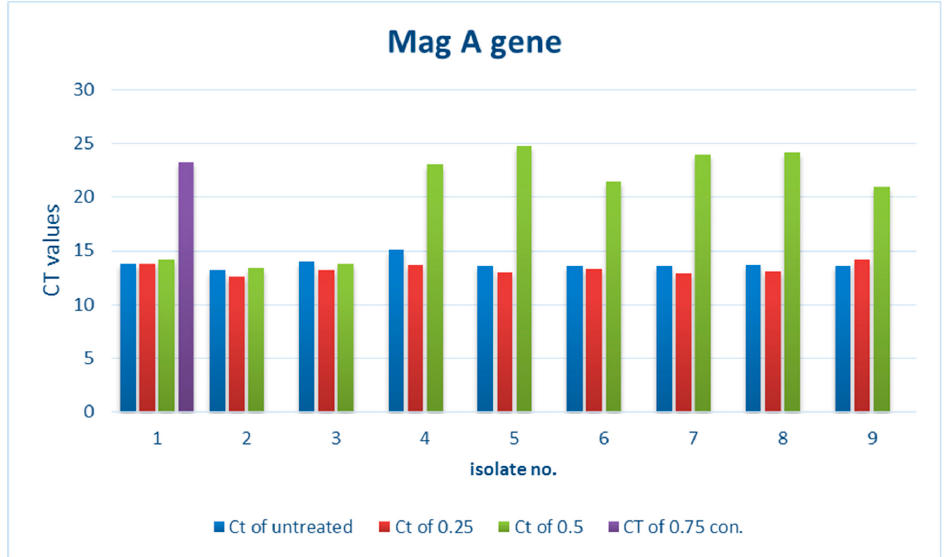
Table 3. k2A gene expression in Klebsiella pneumoniae isolates treated with different concentrations of ZnO NPs *. Treated Bacteria Isolates with Different con.